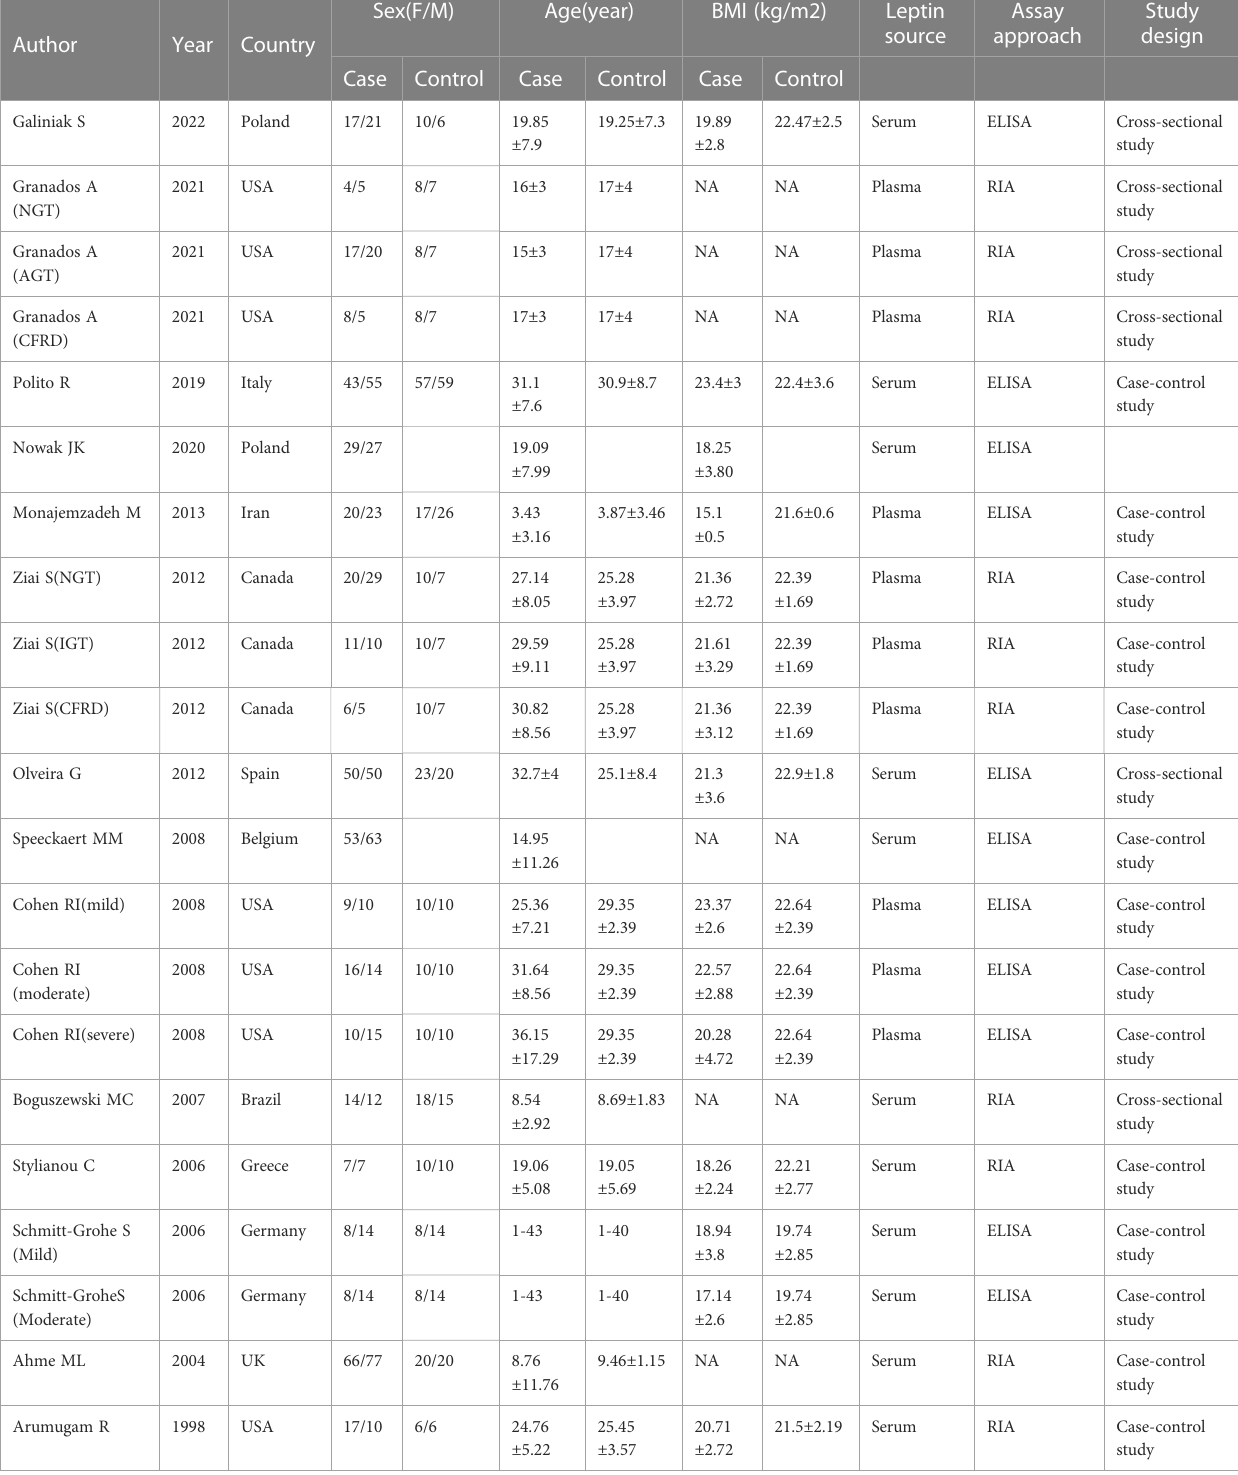
TABLE 1 Characteristics of included